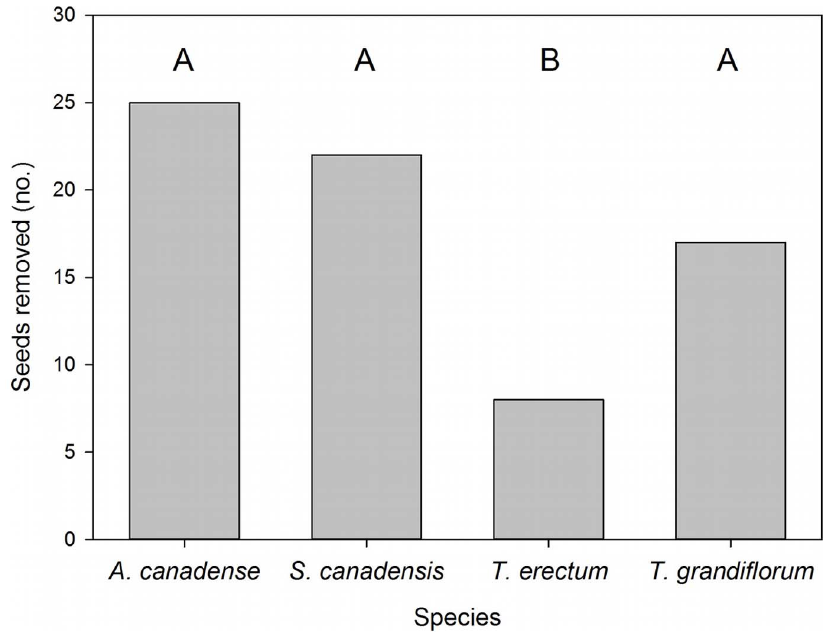
Figure 1. Seed removal by Aphaenogasterrudis workers. Numbers of diaspores of Asarum canadense, Sanguinaria canadensis, Trillium erectum, and Trillium grandiflorum removed by workers within one minute, out of a total of 48 presented to colonies. Time to removal was measured from the time workers first discovered a diaspore. Different letters indicate statistically significant differences in removal, as assessed by full survival analysis models (see text).